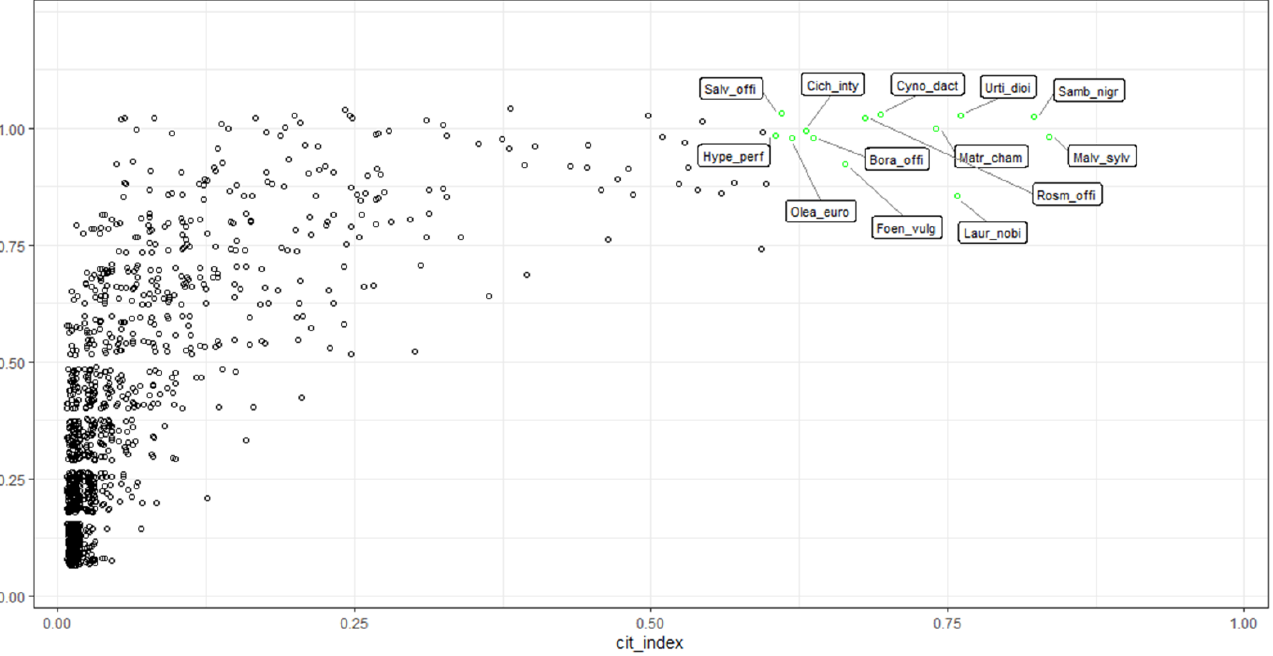
Figure 3. Graphic distribution of the cited medicinal species according to the citation (CI) and use (UI) indexes. To avoid overlapping, dots above 0.8 UI were randomly scattered on the y-axis (±0.1) using the R function geometry_jitter . In green, most relevant species with a CI above 0.6 and UI above 0.8 are shown. Malv_sylv, Malva sylvestris L.; Samb_nig, Sambucus nigra L.; Urti_dio, Urtica dioica L.; Matr_cham, Matricaria chamomilla L.; Cyno_dact, Cynodon dactylon (L.) Pers.; Rosm_offi, Rosmarinus officinalis L.; Bora_offi, Borago officinalis L.; Cich_inty, Cichorium intybus L.; Olea_euro, Olea europaea L.; Hype_perf, Hypericum perforatum L.; Salv_offi, Salvia officinalis L.; Laur_nobi, Laurus nobilis L.; Foen_vulg, Foeniculum vulgare Mill.